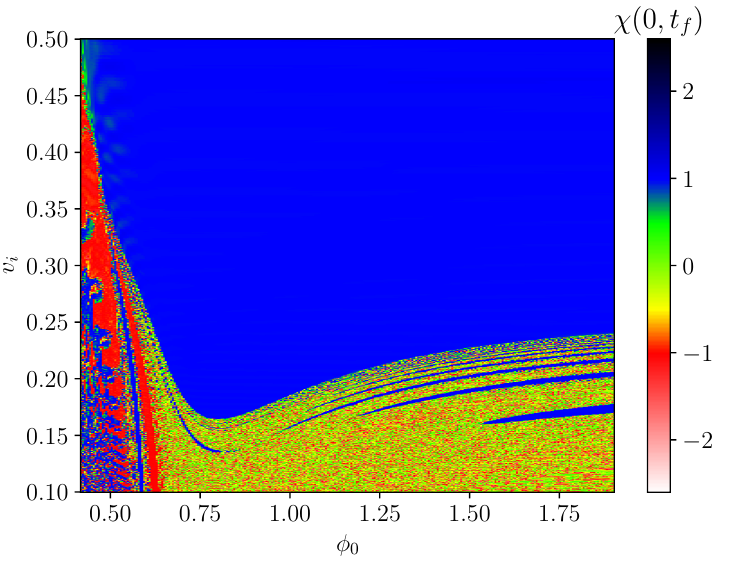
Figure 9 . Final value of the scalar field at the center of the collision as a function of φ 0 and v i . We consider the case where the fermions start at the excited state.